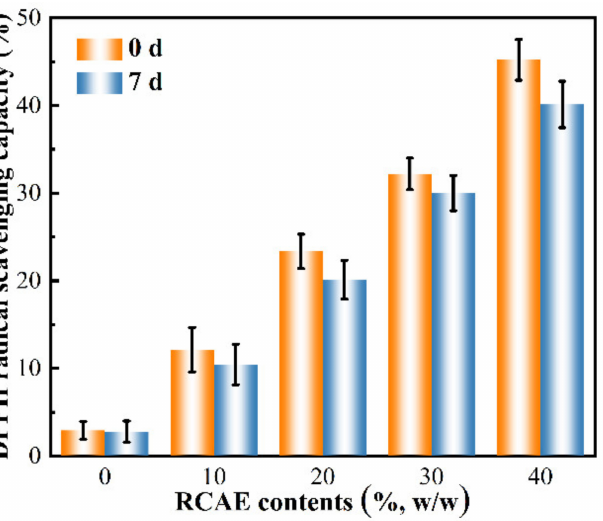
Figure 3. The DPPH radical scavenging capacity of ADSP-based films added by different RCAE contents stored 0 and 7 days placed at 25 ◦